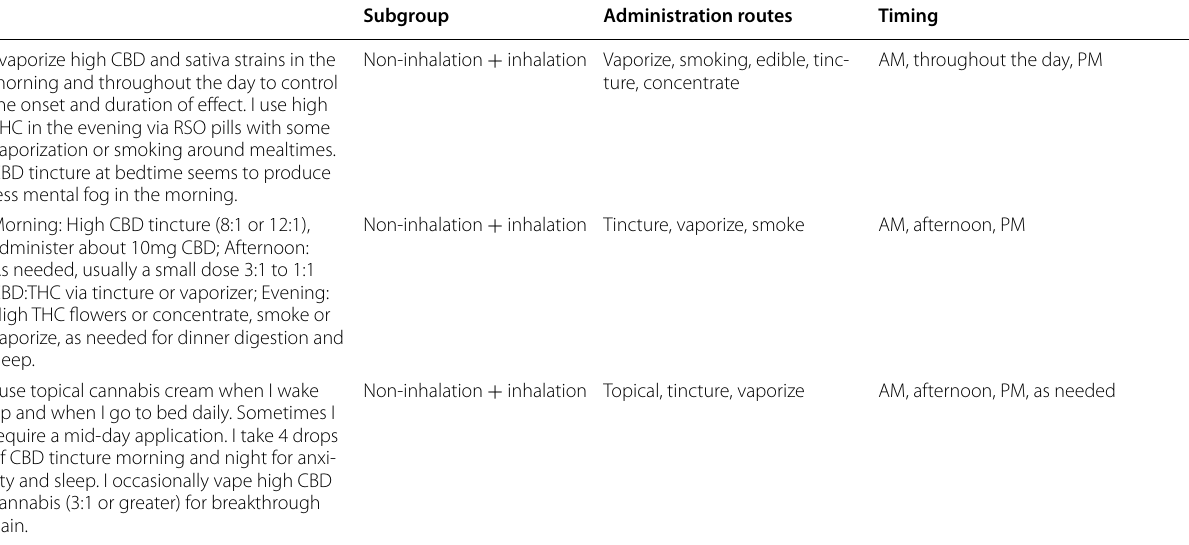
Routines varied in complexity, with some participants using numerous administration routes and cannabinoids at different times of the day THC tetrahydrocannabinol, CBD cannabidiol, AM morning, PM evening, RSO Rick Simpson Oil, PTSD Post-traumatic stress disorder